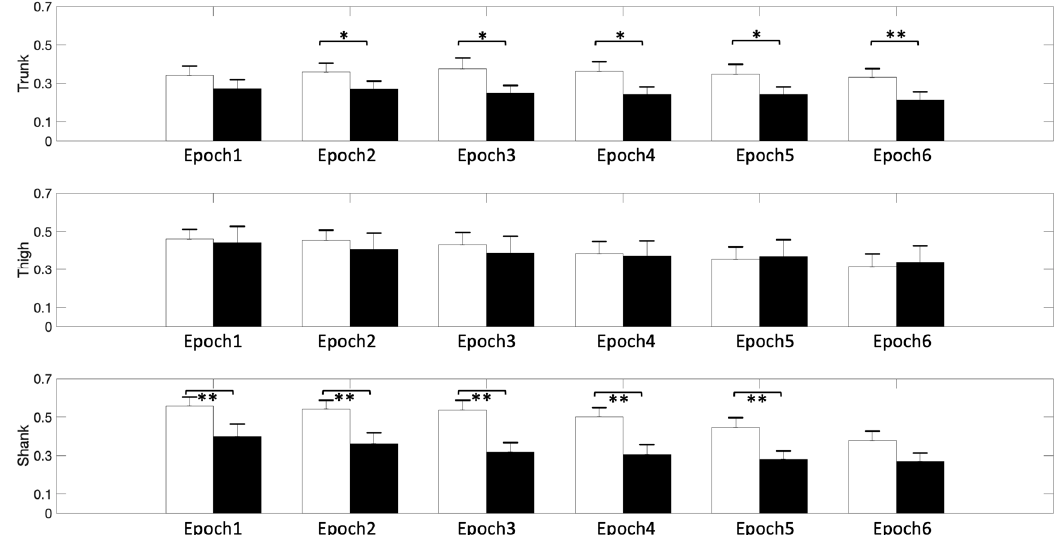
Figure 4. C values of the trunk, thigh, and shank segments for sliding conditions (white) and fixed conditions (black) are shown for each epoch. * represents statistical significance ( p < 0.05) of the factor of sliding board and ** for p < 0.001.